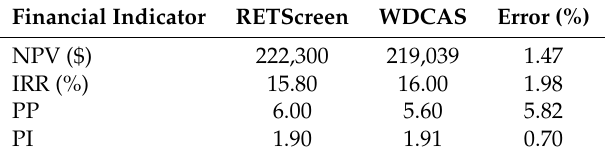
Table 3. Financial indicators comparison between RETScreen and WDCAS